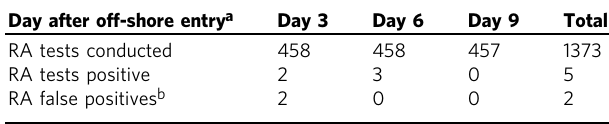
Table 2 Serial offshore BD Veritor rapid antigen tests, positives, and false positives on days 3, 6, and